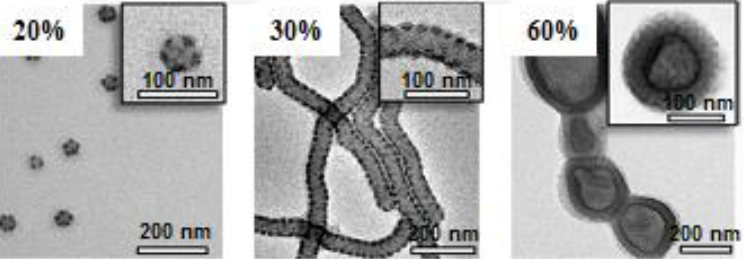
Figure 8. Micellar morphological changes of PS-PB-PMMA triblock terpolymers in acetone/isopropanol mixtures as a function of isopropanol content. “Reprinted with permission from